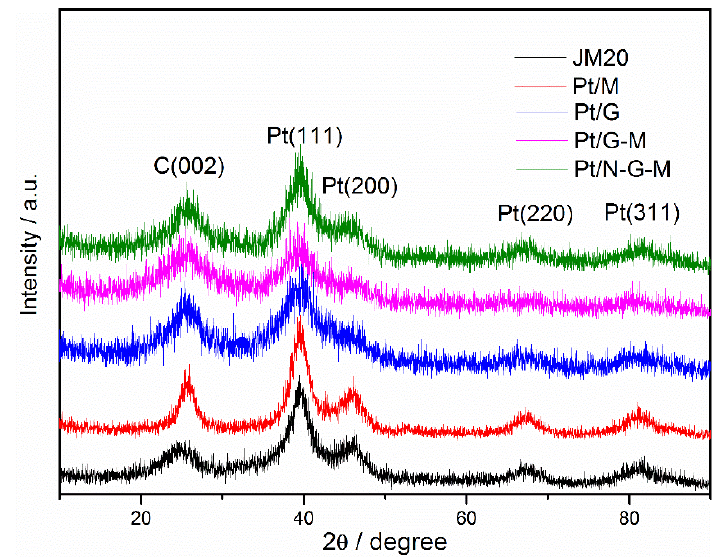
Figure 4. XRD patterns of JM20, Pt/M, Pt/G, Pt/G-M, and Pt/N-G-M catalysts.